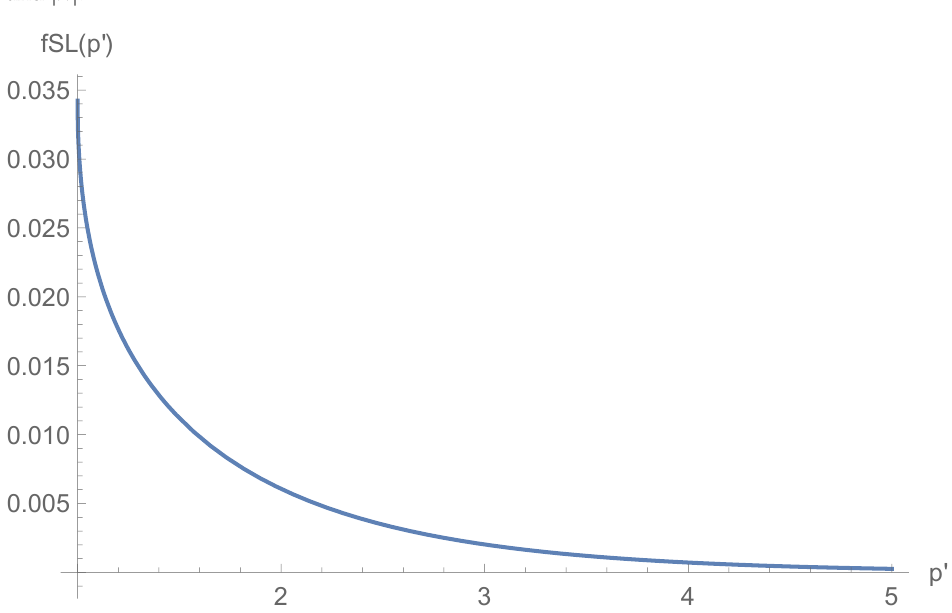
Figure 21. Probability density function for free superluminal Lorentzian particle as a function of p (cid:48) and | λ | .